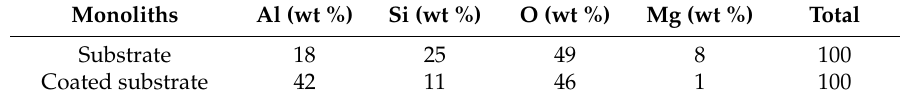
Table 5. Elemental composition of uncoated and 200M10 samples determined by EDS analysis.